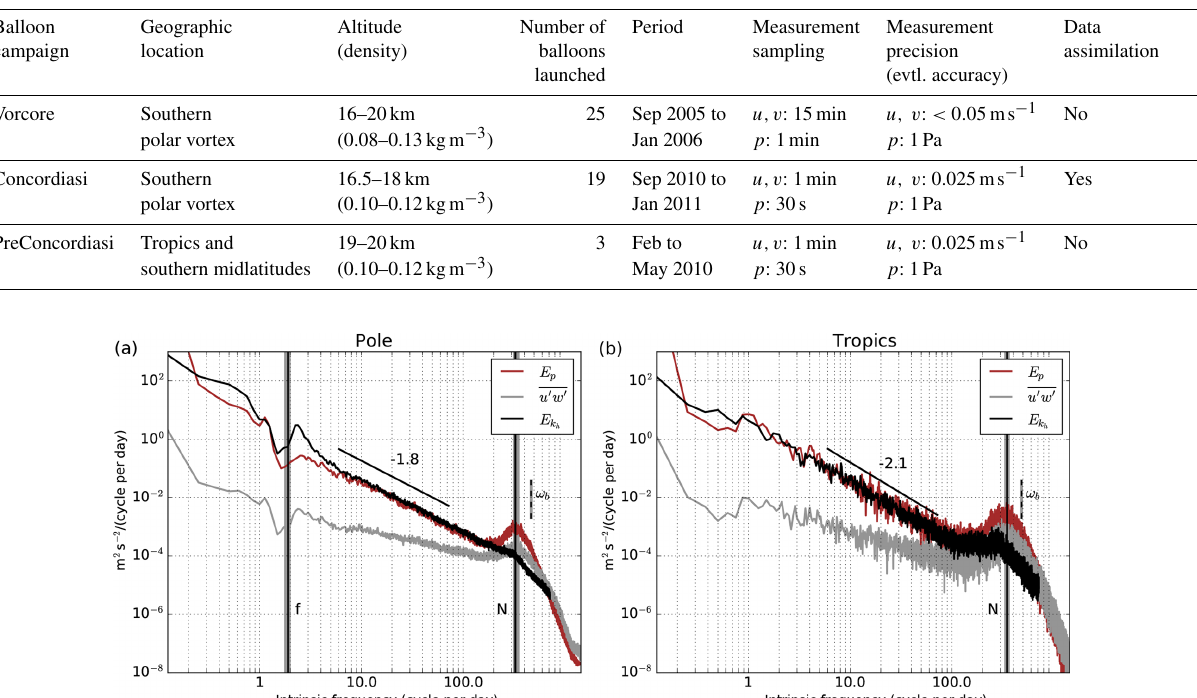
Figure 1. Average spectra of horizontal kinetic energy E k (a) polar and (b) equatorial balloon campaigns in